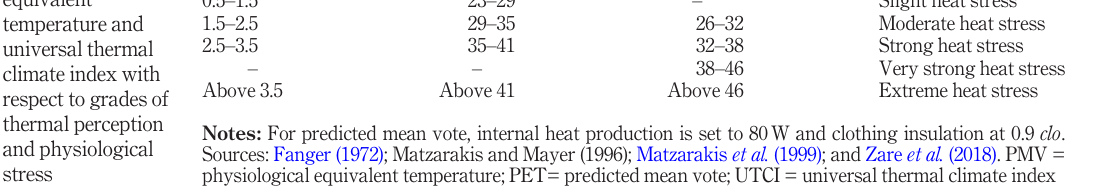
Table 2. Ranges of thermal indices, including predicted mean vote, physiological equivalent temperature and universal thermal climate index with respect to grades of thermal perception and physiological stress